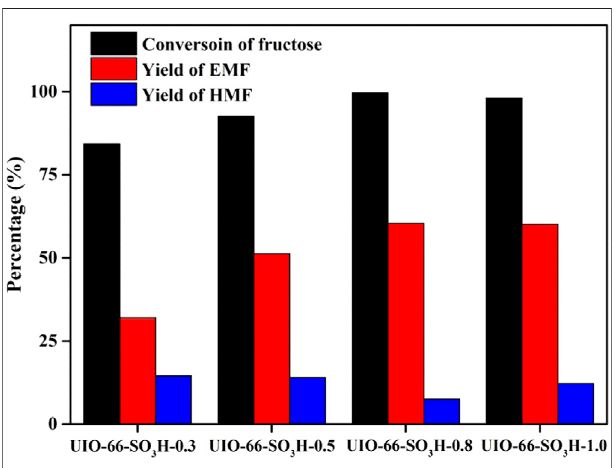
FIGURE 6 | Results of alcoholysis of fructose catalyzed by UIO-66- SO